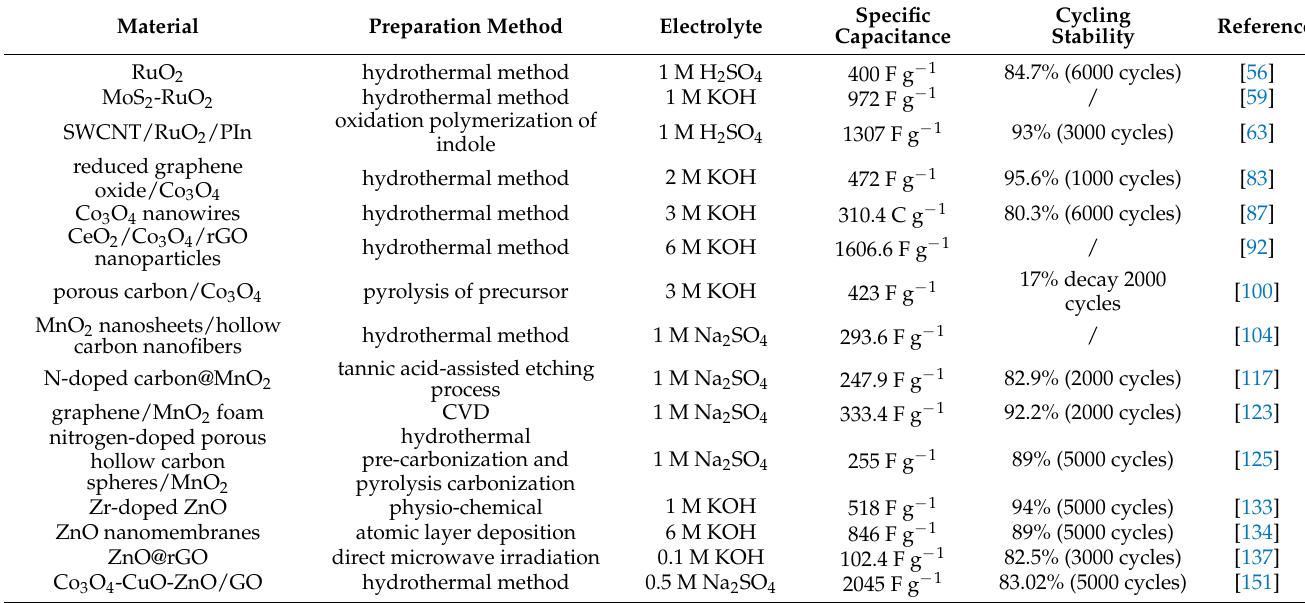
Table 1. The electrochemical performance of representative binary transition metal oxides (TMOs) electrode materials. SWCNT, single-walled carbon nanotube; CVD, chemical vapor